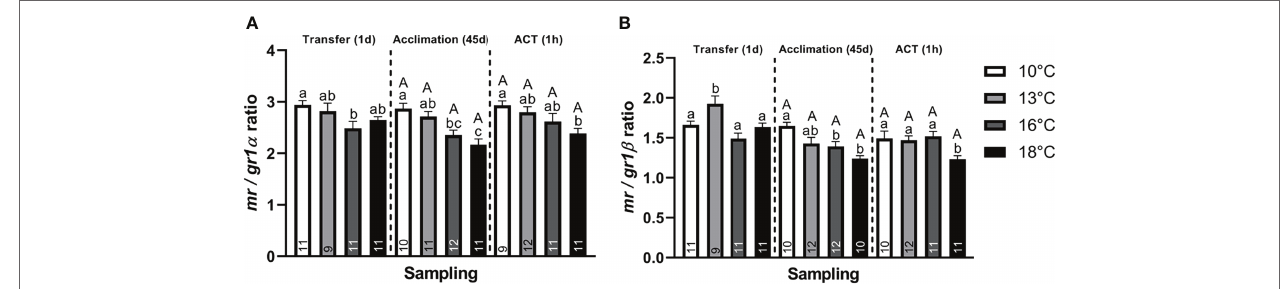
FIGURE 3 | Change in the CR ratio for (A) mr/gr1 α and (B) mr/gr1 β of whole telencephalon at Transfer (1d), Acclimation (45d), and ACT (1h). Values are presented as averages ± SEM of each treatment, with sample (n) indicated within each treatment bar of the figure. Uppercase letters indicate significant difference within a